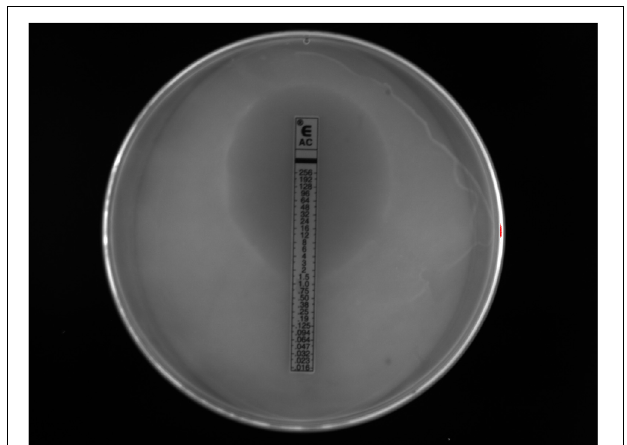
FIGURE 7 | A visible zone of Helicobacter enhydrae growth inhibition around an ETEST R (cid:13) amoxicillin (AC) gradient strip on CHBA media showed this trial with a minimum inhibitory concentration at 1.0 µ